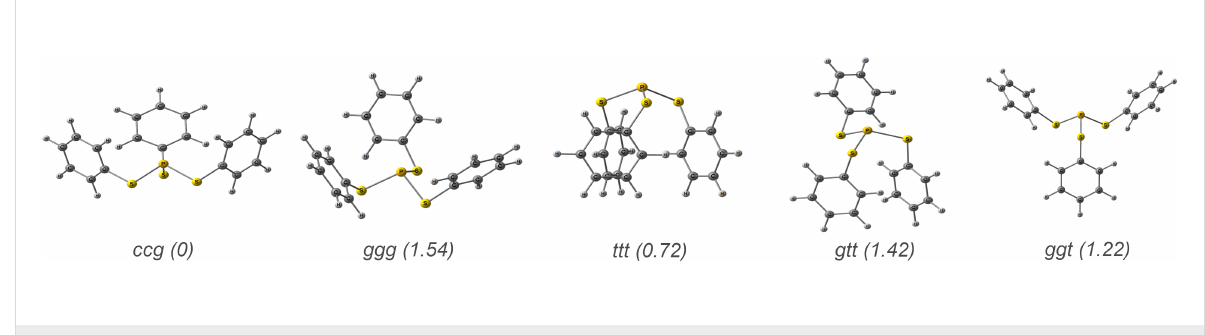
Figure 5: Quantum chemically optimized conformations of the (PhS) 3 P molecule and their relative energies (kcal/mol).